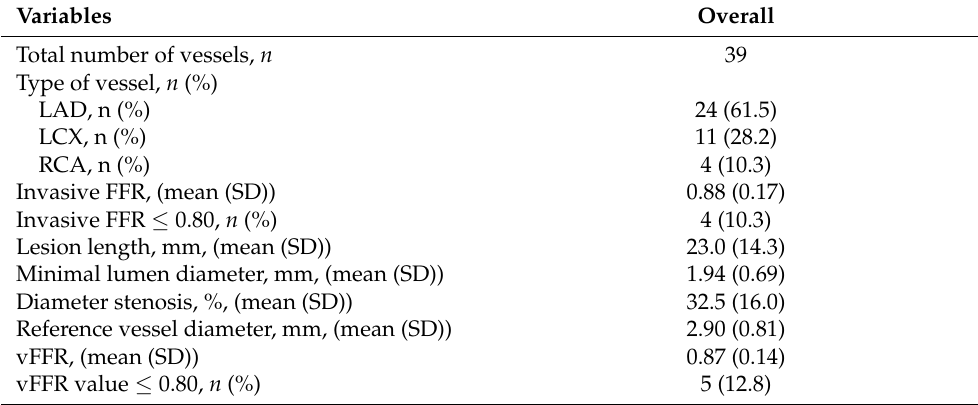
Table 2. Patient procedural characteristics.